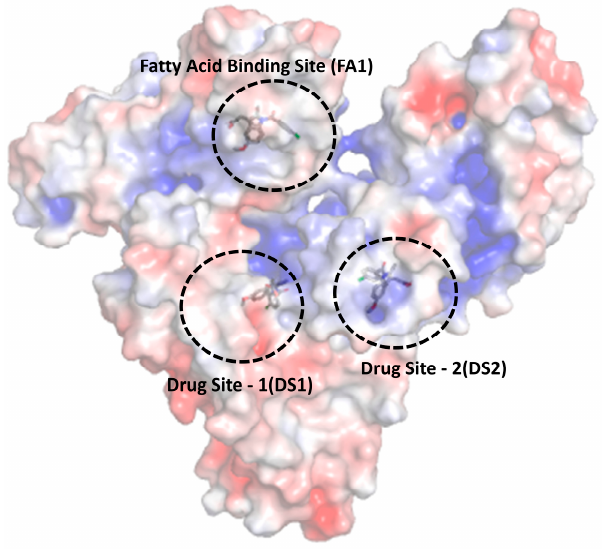
Figure 9. Electrostatic surface potential map of three sites of human serum albumin with indometh- acin. Red (negative potential), blue (positive potential), and white (neutral potential). Table 7. Time-averaged structural properties obtained from molecular dynamics simulation of free HSA and indomethacin bound to three sites of